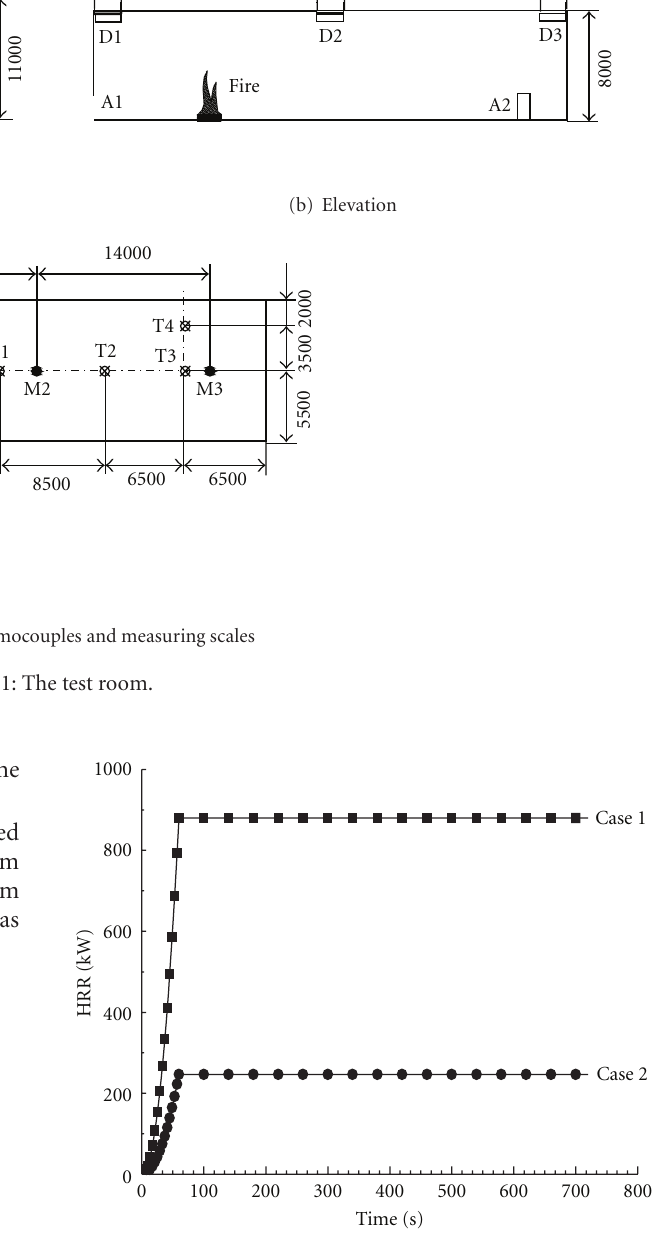
Figure 2: Input heat release